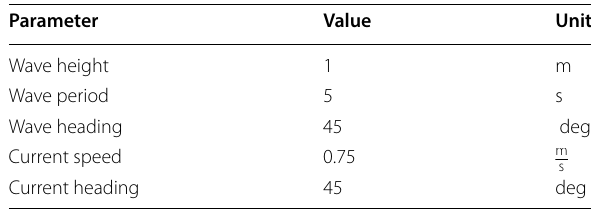
Table 2 Wave conditions used in investigatin the fixed